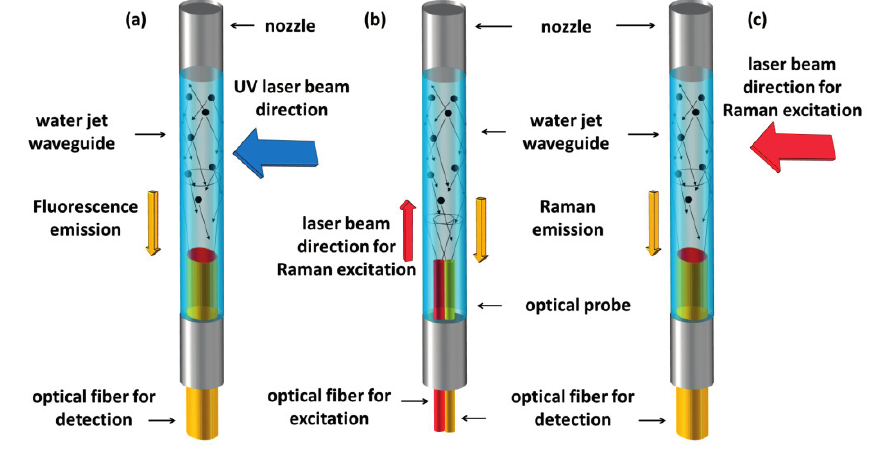
Figure 3. Schematic of the optofluidic device based on a water jet waveguide. ( a ) Configuration for fluorescence spectroscopy; ( b ) Configuration for